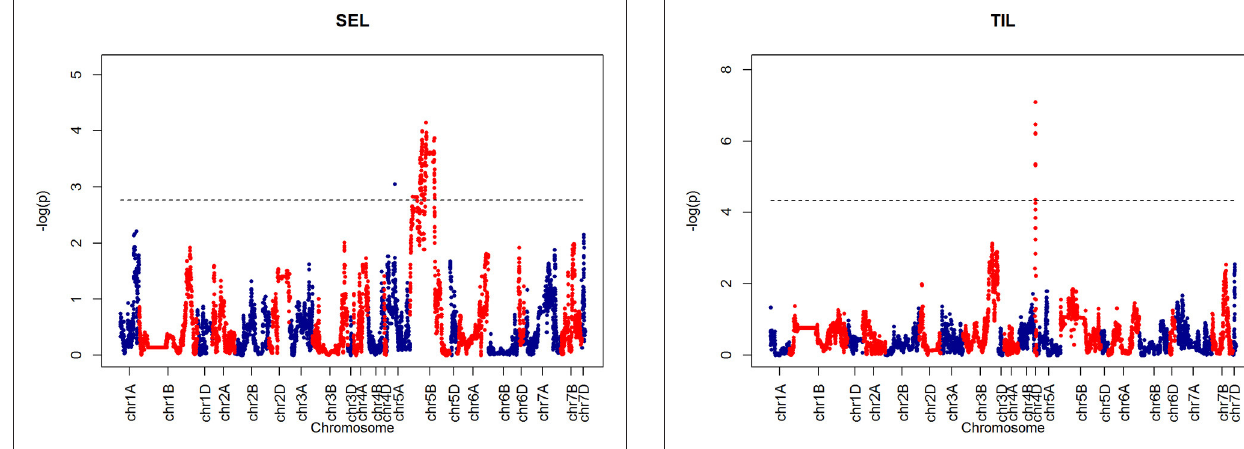
FIGURE 9 | QTLs markers for the trait SEL. Dashed lines indicate threshold (FDR < 0.05, logP4).